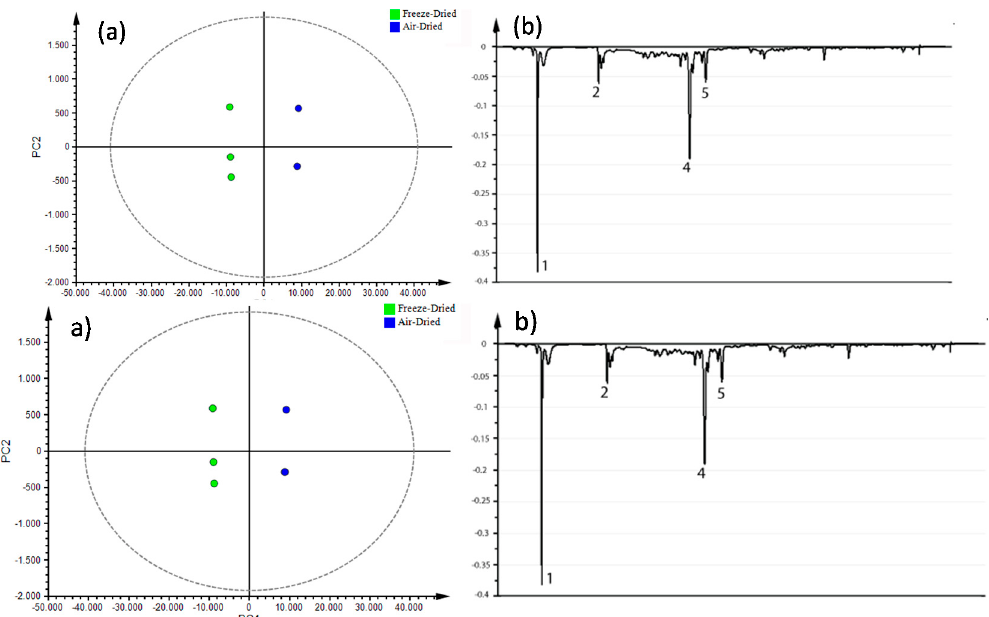
Figure 8. ( a ) OPLS-DA score plot for individual flower extracts profiled by LC / MS used for testing, discriminated by drying process method. Internal cross-validation produced a Q 2 of 0.890, clearly well within acceptable limits. Centered autoscaling. ( b ) Loading line of metabolites detected by LC / MS with annotated compounds: Scopoletin ( 1 ), naphthalenone ( 2 ), rhamnetin 3-glucoside ( 4 ), and unidentified compound ( 5 ) with an m / z of 492.